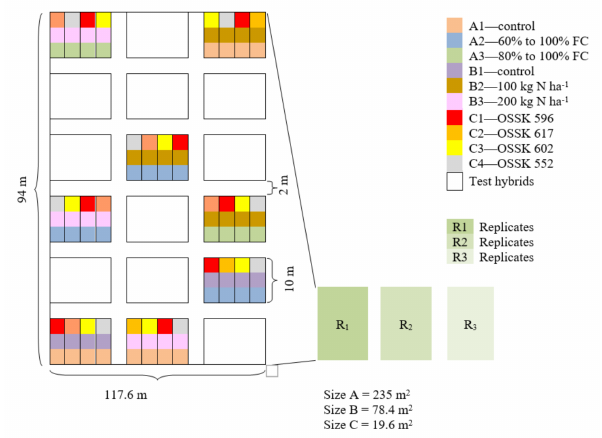
Figure 1. Experimental plot design.